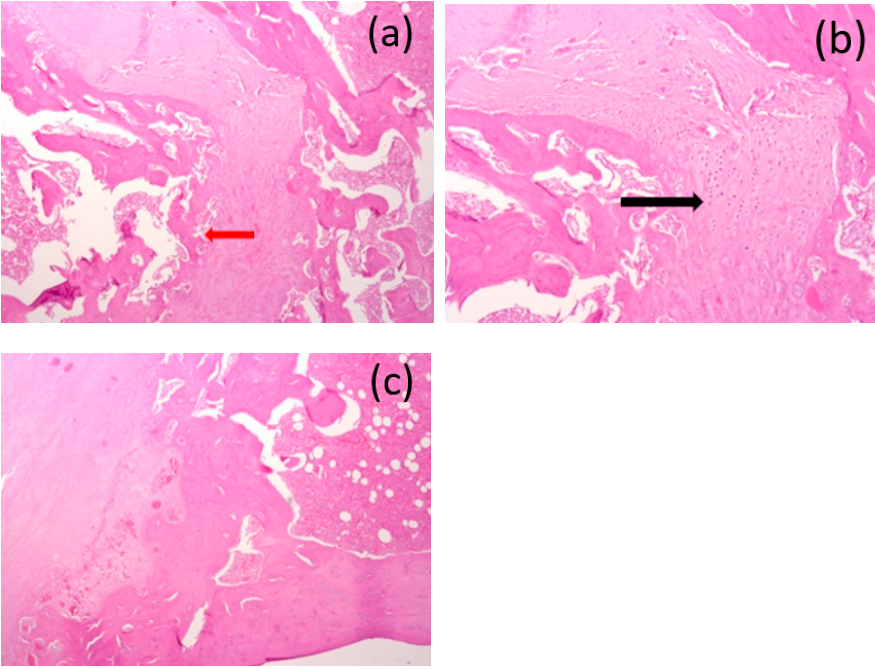
Figure 16. ( a – c ) Images of the histological preparations of a sample removed after 3 months and stained with hematoxylin and eosin, using a microscope at magnifications of ×50 ( a ), ×100 ( b ), and ×100 ( c ).